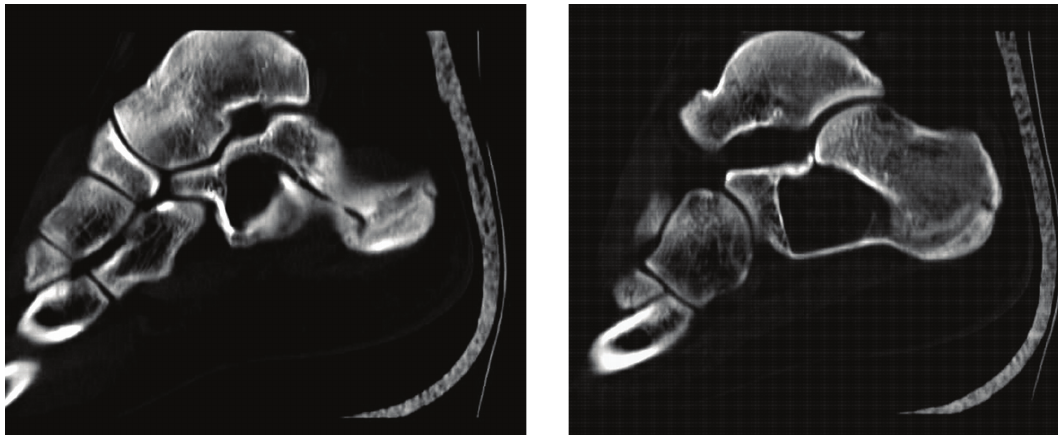
Figure 3: CT scan views on the sagittal plane showing an undisplaced pathologic fracture over a simple calcaneal cyst.